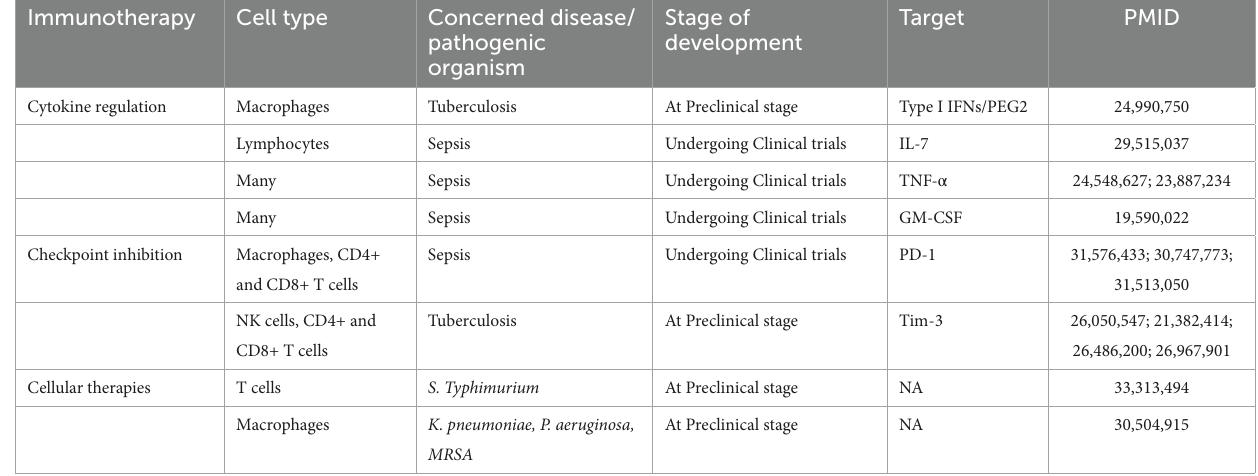
TABLE 1 Evolution of immunotherapies for bacterial diseases/infections (74).